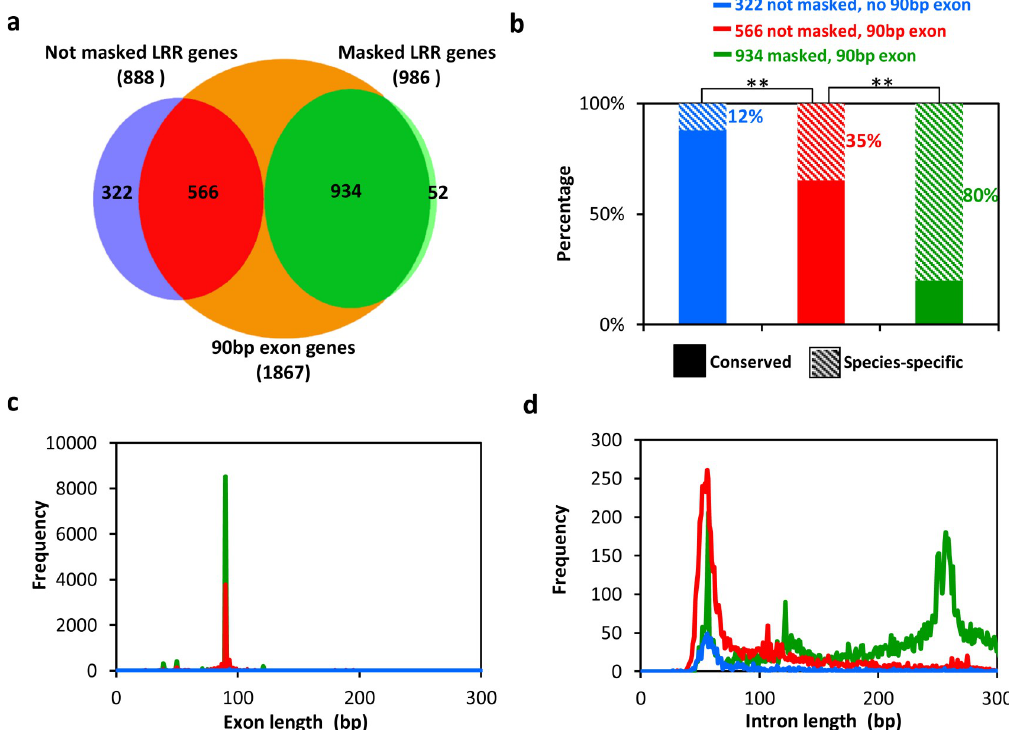
Fig 5. T . thermophila LRR genes can be sorted into 3 groups with different properties. (a) LRR genes are sorted into 3 groups based on the presence or absence of 90-bp exons and on MAC CRS masking. (b) Ratios of species-specific to conserved genes among the 3 groups of LRR genes. Two asterisks indicate a significant difference between 2 groups (chi-squared test, p < 1 × 10 − 5 ). (c) Exon length distributions of the 3 groups of LRR genes. (d) Intron length distributions for the 3 groups of LRR genes. Colors in (c) and (d) are as in (b). CRS, consensus repeat sequence; LRR, leucine-rich repeat; MAC, macronucleus.